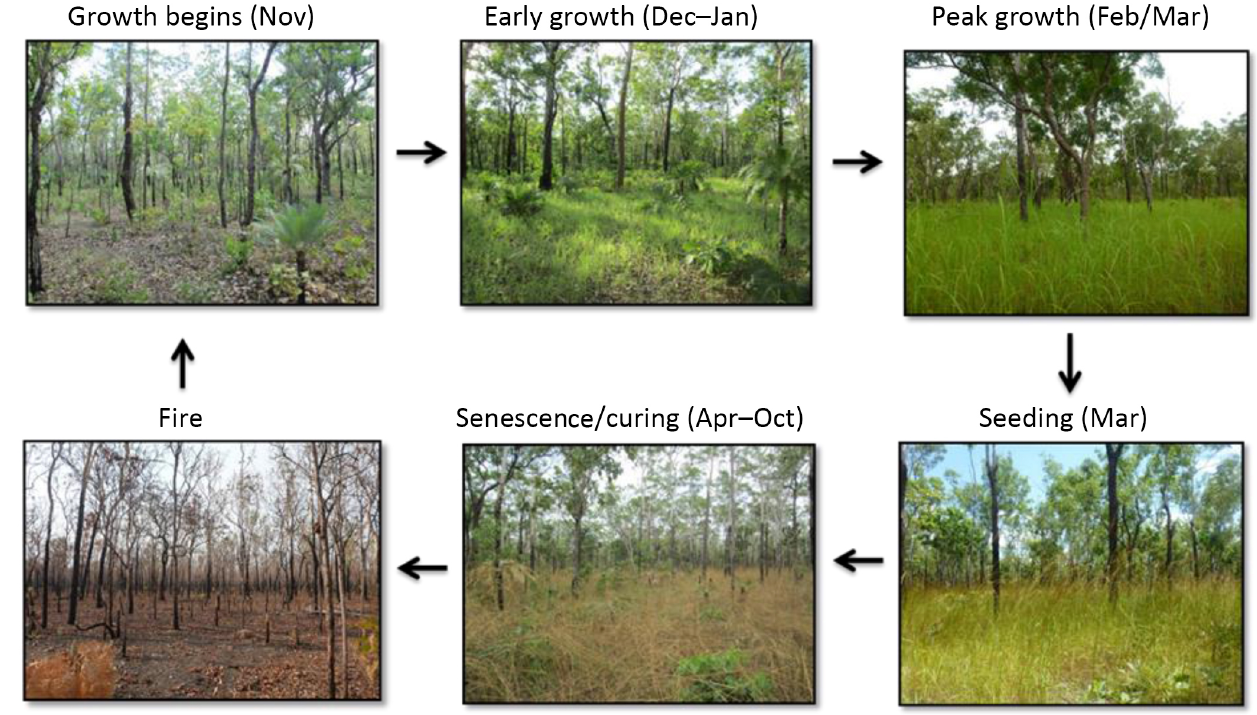
Figure 1. The variability in understory vegetation at Howard Springs OzFlux site, Northern Territory, Australia. The months from late October to early November are when growth in the understory begins, which continues on through the wet season until the end of March and start of April, when the understory grasses senesce and cure. The understory remains dry throughout the dry season months unless fire removes dry